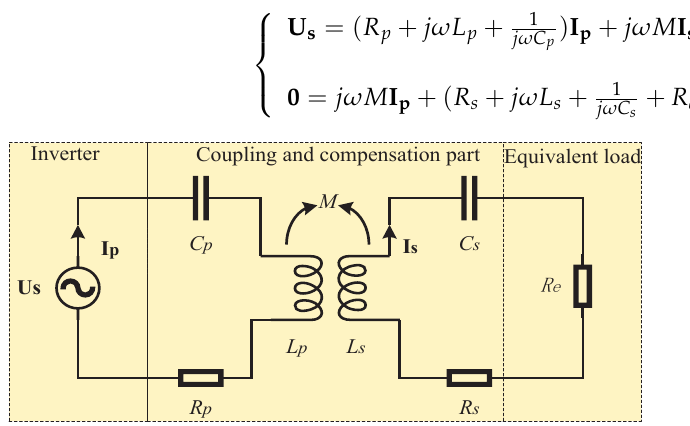
Figure 1. Equivalent circuit model of S-S compensated